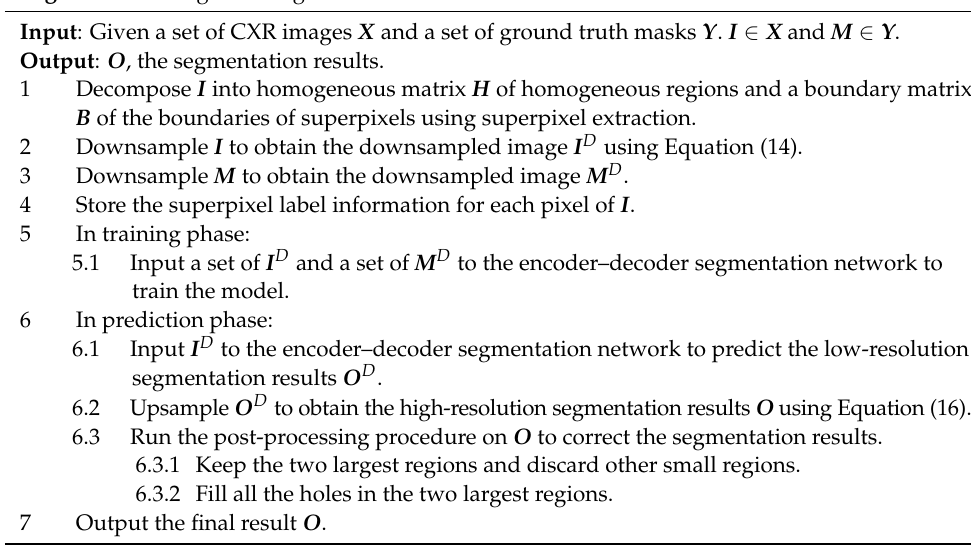
Algorithm 1 . Lung Field